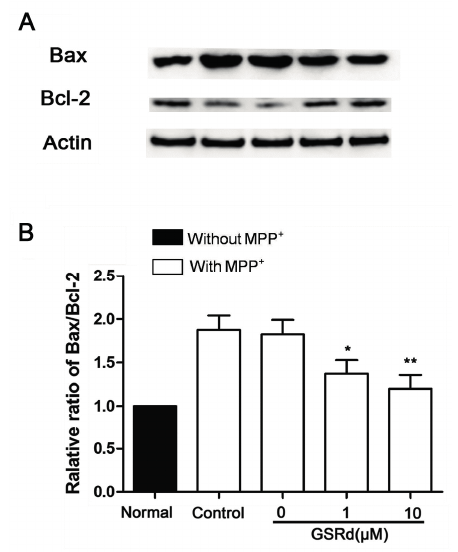
Figure 4. Effects of ginsenoside Rd (GSRd) on Bax expression and Bax/Bcl-2 ratio